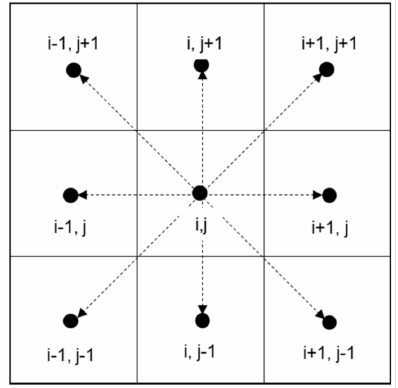
Figure 4. Least squares cell-point-cell stencil.